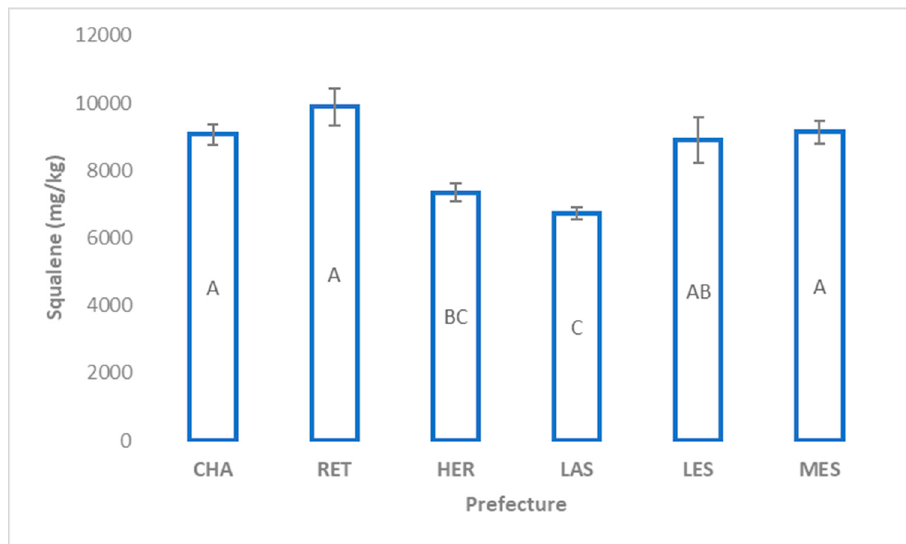
Figure 1. Content of squalene (mean ± standard error) in extra virgin olive oils (EVOOs) from the Koroneiki cultivar produced in various regions of Greece. Different letters indicate significant differences (Tukey’s HSD test, p ≤ 0.05) between the prefectures. CHA: Chania; HER: Heraklion; LAS: Lasithi; RET: Rethymno; LES: Lesvos; MES: Messenia. α -Tocopherol was the dominant homologue in EVOOs, representing 94.6% of the total tocol content with a mean value of 116 mg/kg. Its concentration ranged from 79 to 151 mg/kg for samples